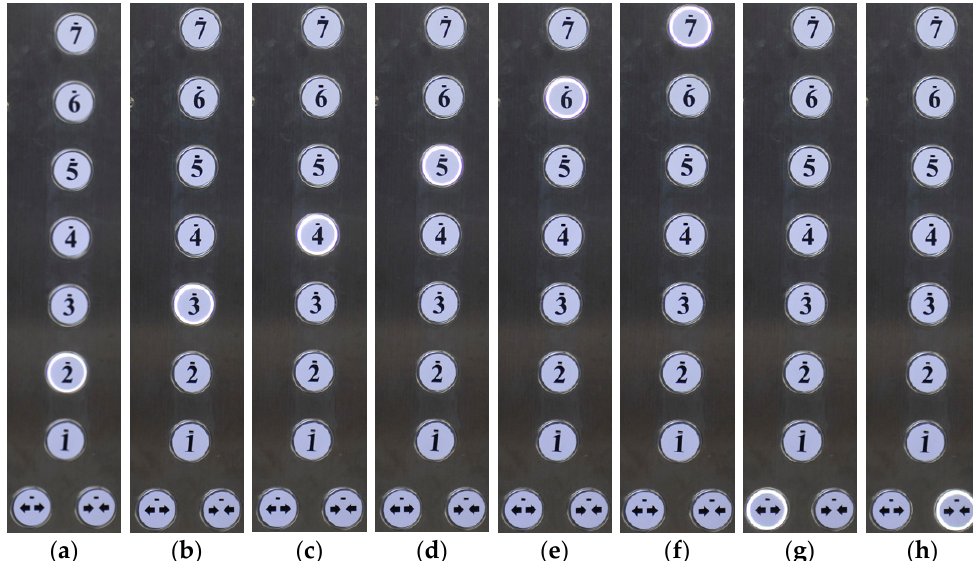
Figure A3. Operation of contact-free perceptual buttons in the elevator car. ( a ) 2F button lights up; ( b ) 3F button lights up; ( c ) 4F button lights up; ( d ) 5F button lights up; ( e ) 6F button lights up; ( f ) 7F button lights up; ( g ) Open button lights up; ( h ) Close button lights up.